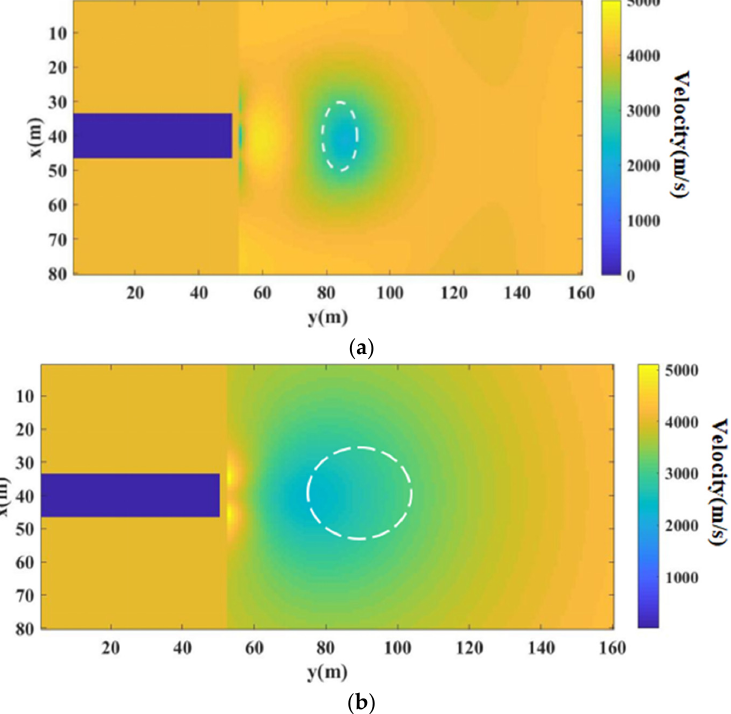
Figure 12. ( a ) FWI result of 10 m karst cave numerical model. ( b ) FWI result of 30 m karst cave numerical model. numerical